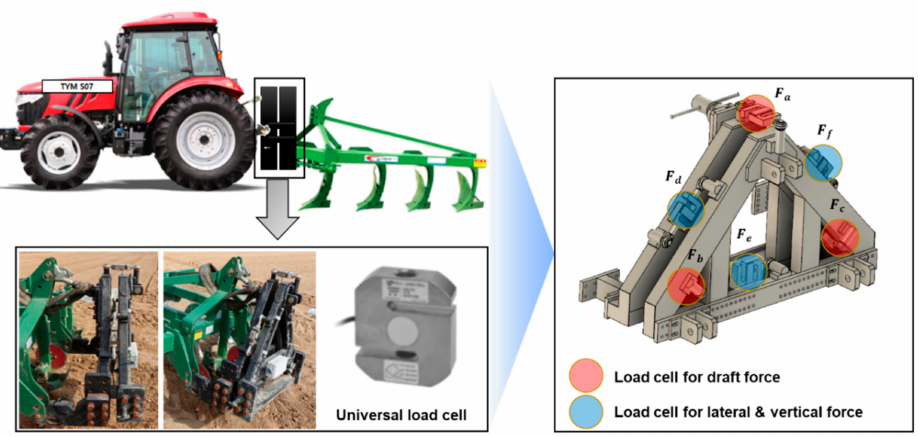
Figure 4. Configuration of the draft force measurement system.